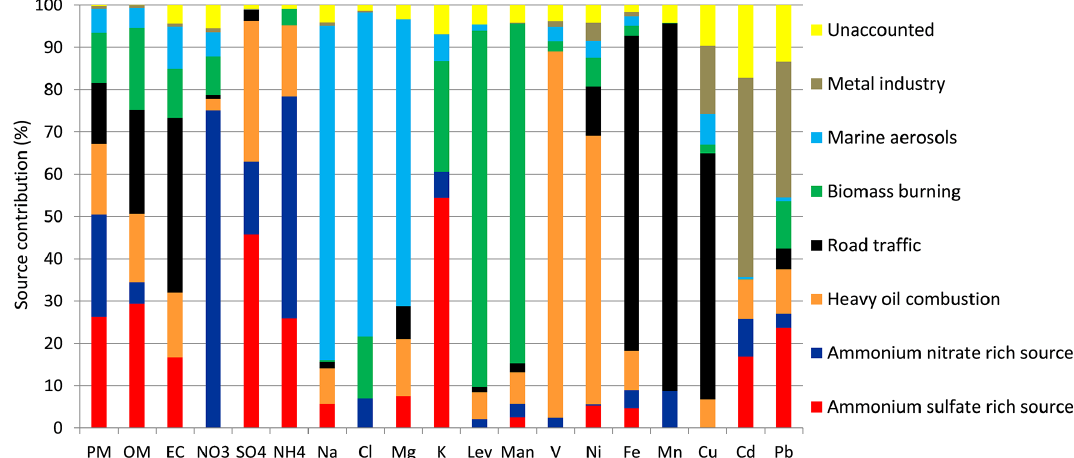
Figure 4. Source contribution (%) of each chemical species (median of the bootstrap results, n = 100). Lev: levoglucosan, Man: mannosan, Unaccounted: proportion of a chemical species that is not attributed to any